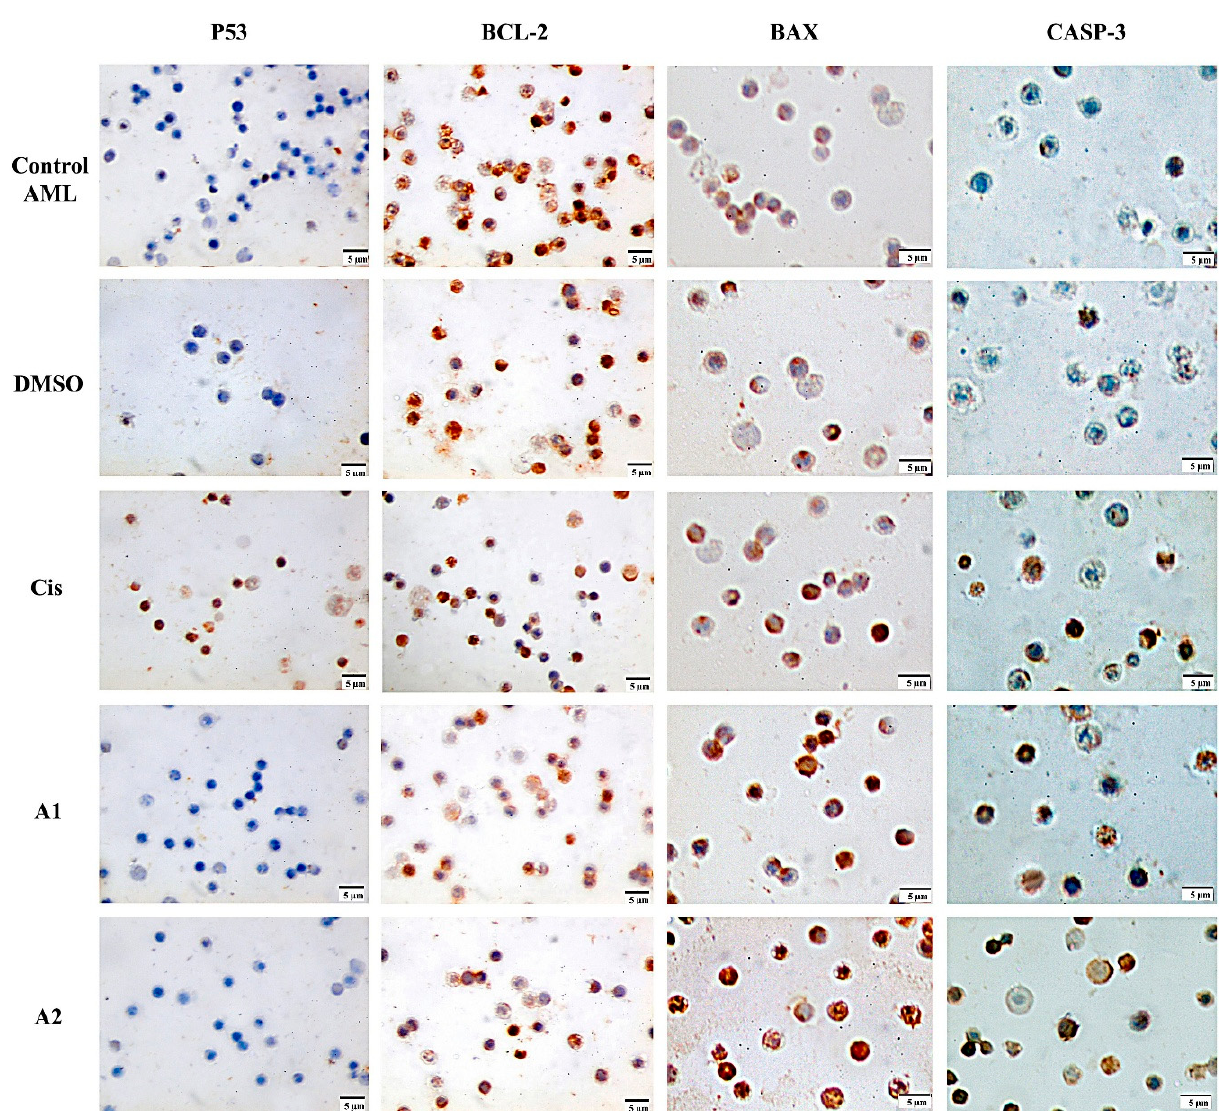
Figure 7. Representative photomicrographs of control and treated AML cells after 3 h of incubation. Protein levels as evaluated by immunocytochemical reactivity (brown staining); negative p53 (blue staining) was observed in control and treated groups, and positive reactivity with brown staining development in the cisplatin group. Decreased BCL-2 protein immunoreactivity was observed, whereas elevated levels of BAX and Caspase-3 (CASP-3) protein expression were noticed with different treatments. A1: A. hierochuntica methanolic extract (0.5 μ g/mL); A2: (3.0 μ g/mL); Cis: cisplatin (3.0 μ g/mL).